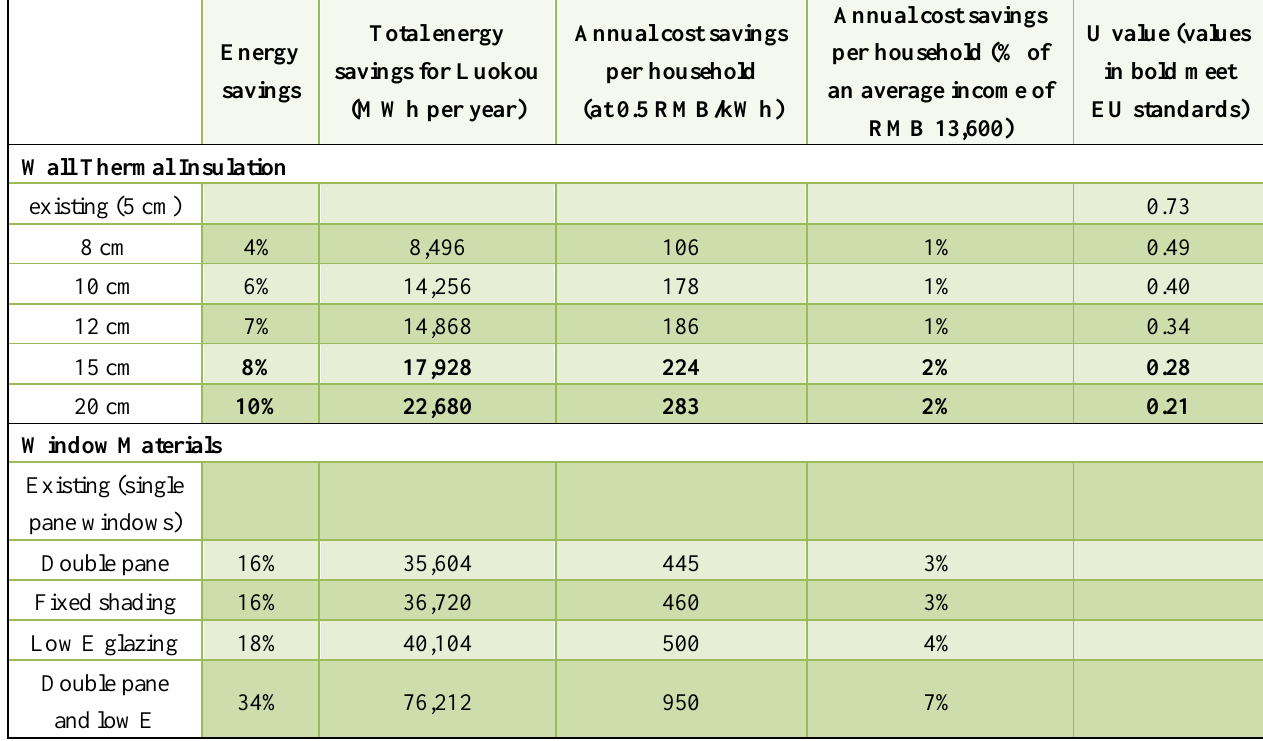
Table 1. Scenarios for achieving energy savings in buildings by improving the thermal insulation of walls and the performance of